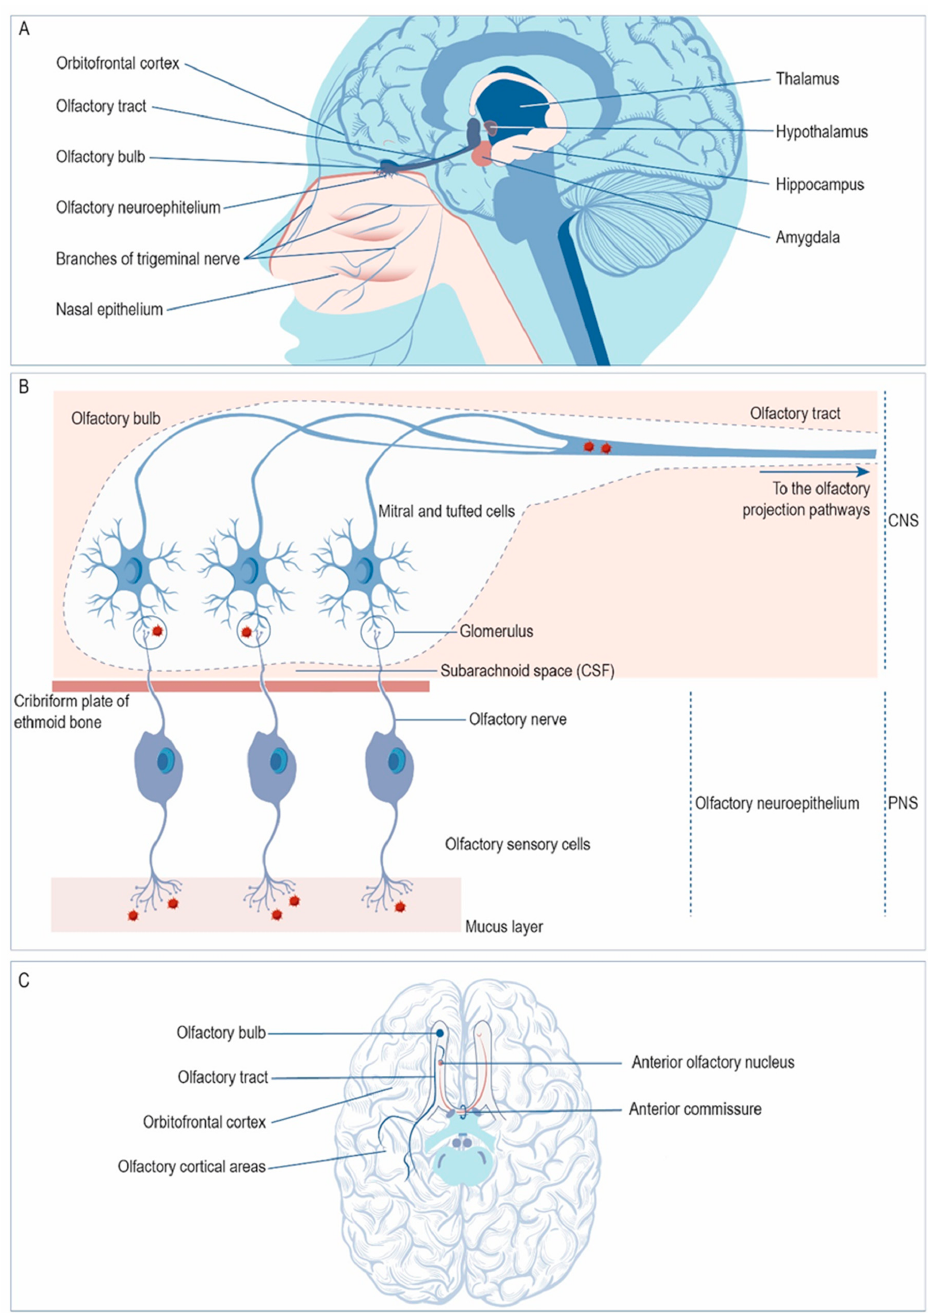
Figure 2. Spread of herpes simplex virus type 1 (HSV-1) to the central nervous system (CNS) via the olfactory nerve. ( A ) HSV-1 may enter the CNS via the olfactory neuroepithelium. From there, the virus may reach the olfactory bulb and then spread through the olfactory tract to reach limbic structures, such as the hippocampus, amygdala, or orbitofrontal cortex. ( B ) HSV-1 may reach the olfactory bulb infecting olfactory sensory cells, whose axons cross the ethmoid bone through the cribriform plate. These neurons form synapses with mitral and tufted cells in the glomeruli. The virus may infect these cells trans-synaptically at the glomeruli and spread towards the olfactory projection pathways. ( C ) Once in the olfactory tract, the virus may access the ipsilateral projection areas, such as the orbitofrontal cortex, via the lateral olfactory stria (in blue), or they may reach the contralateral olfactory structures through the anterior commissure via the medial olfactory stria (in red). (Structures are schematically represented and are not drawn to